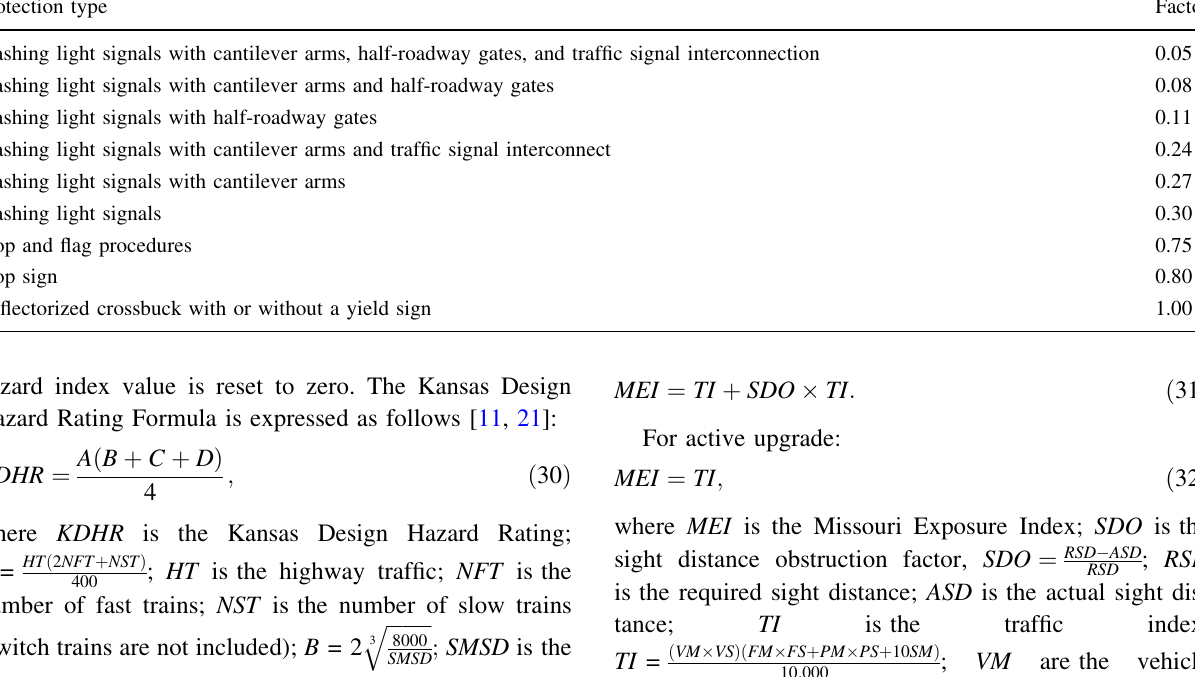
Table 9 Protection factor values used by the Michigan DOT Protection